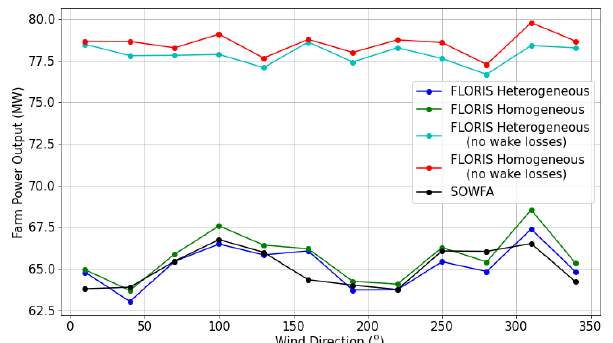
Figure 13. Total wind farm power output calculated using the ho- mogeneous and heterogeneous FLORIS models, with and without wake losses. The results of the SOWFA simulation are also plotted for reference in black.